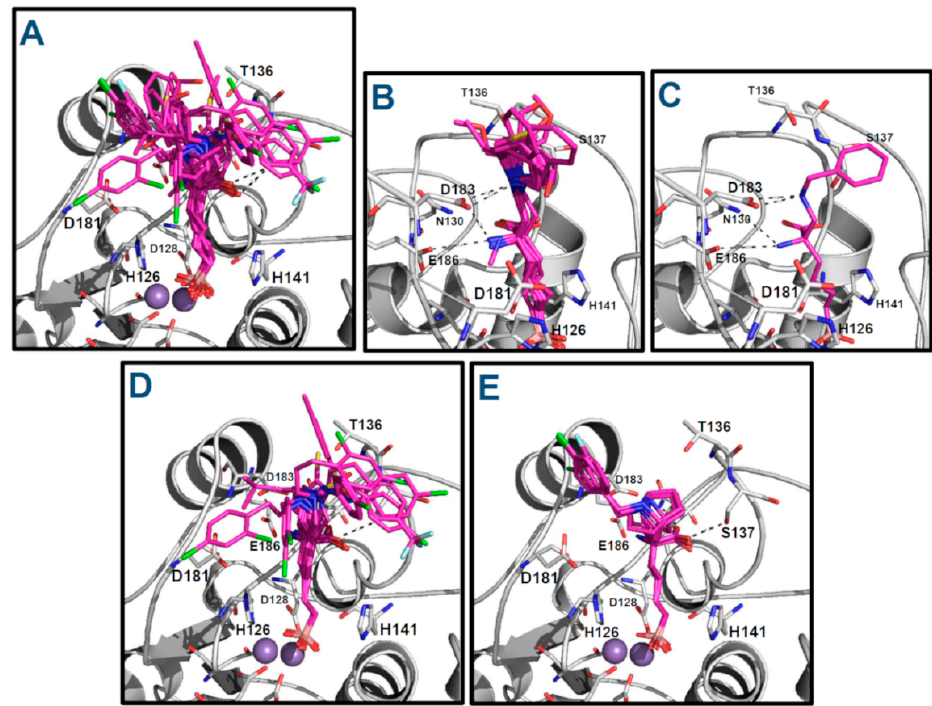
Figure 5. Binding modes of the ABH derivatives as hARGI inhibitors: ( A ) binding modes of the whole dataset; ( B ) binding modes of compounds of the series p1_x and compound p2_1m ; ( C ) binding mode of compound p2_1l ; ( D ) binding modes of compounds of the series p3_2x ; and ( E ) binding modes of compounds of the series p3_11x .